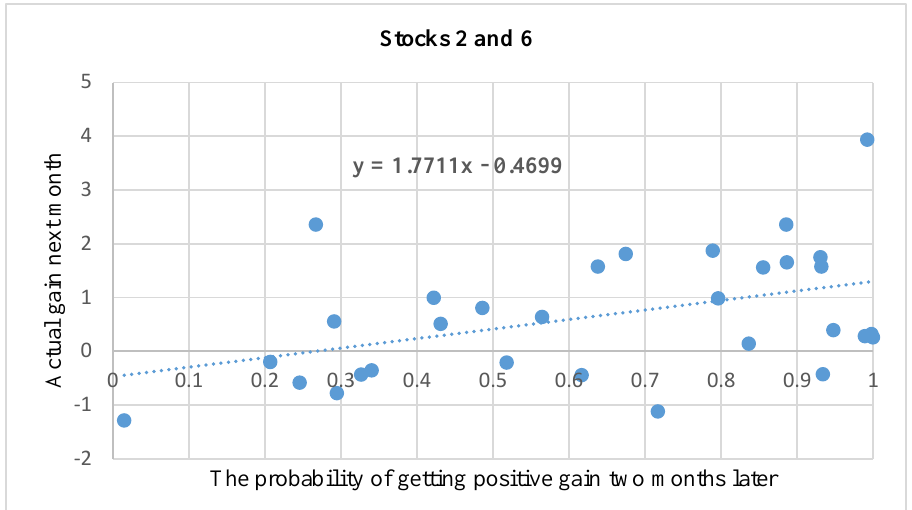
Fig. 3. The results of the regression of actual gain next month on the probability of getting positive gain two months later when stocks 2 and 6 are